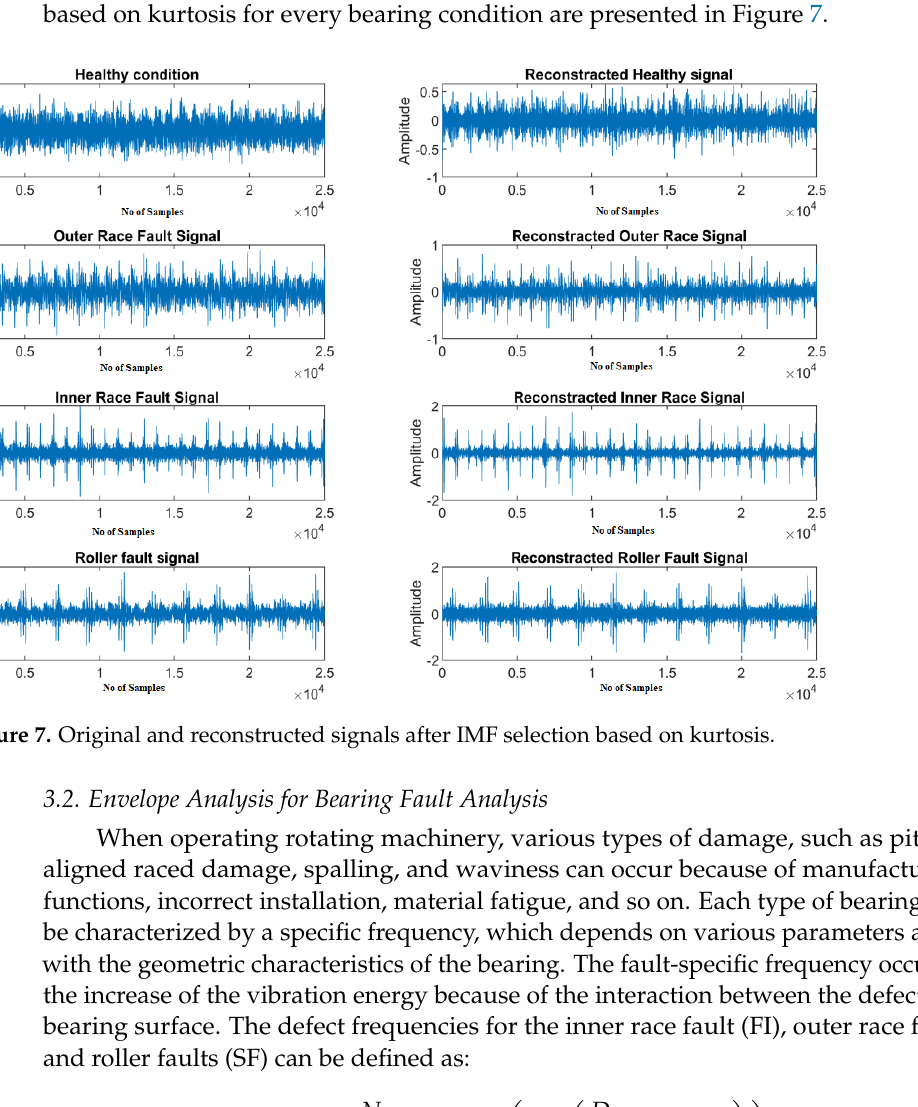
Figure 6. Kurtosis value for different bearing conditions. The original signals and reconstructed signals after removing the unnecessary IMFs based on kurtosis for every bearing condition are presented in Figure 7.